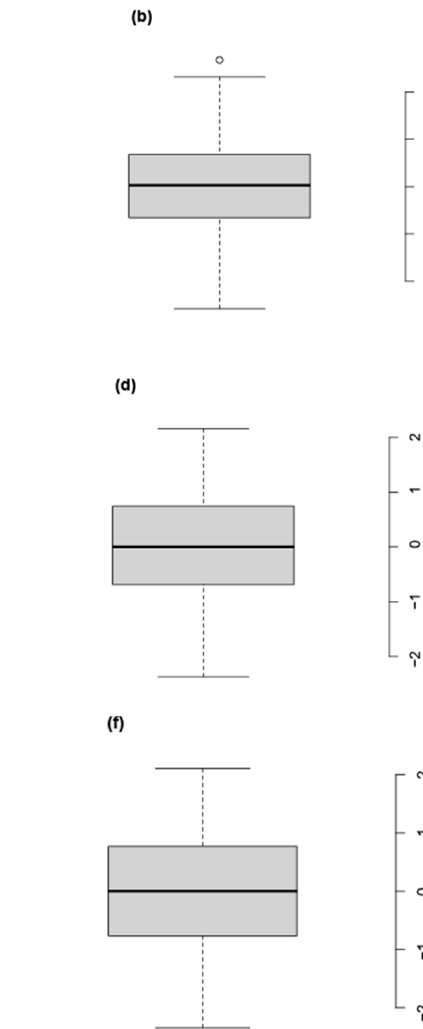
Figure 3. NDVI time series for the period 2001–2015. 3.3. Relations between Droughts and Vegetation Note that for all wavelet correlation figures, significant consistencies at 5% are out- lined in white inside the cone of influence delimited by the shaded area within which colors are most vivid. Additionally, we reported the best-averaged correlations outlined